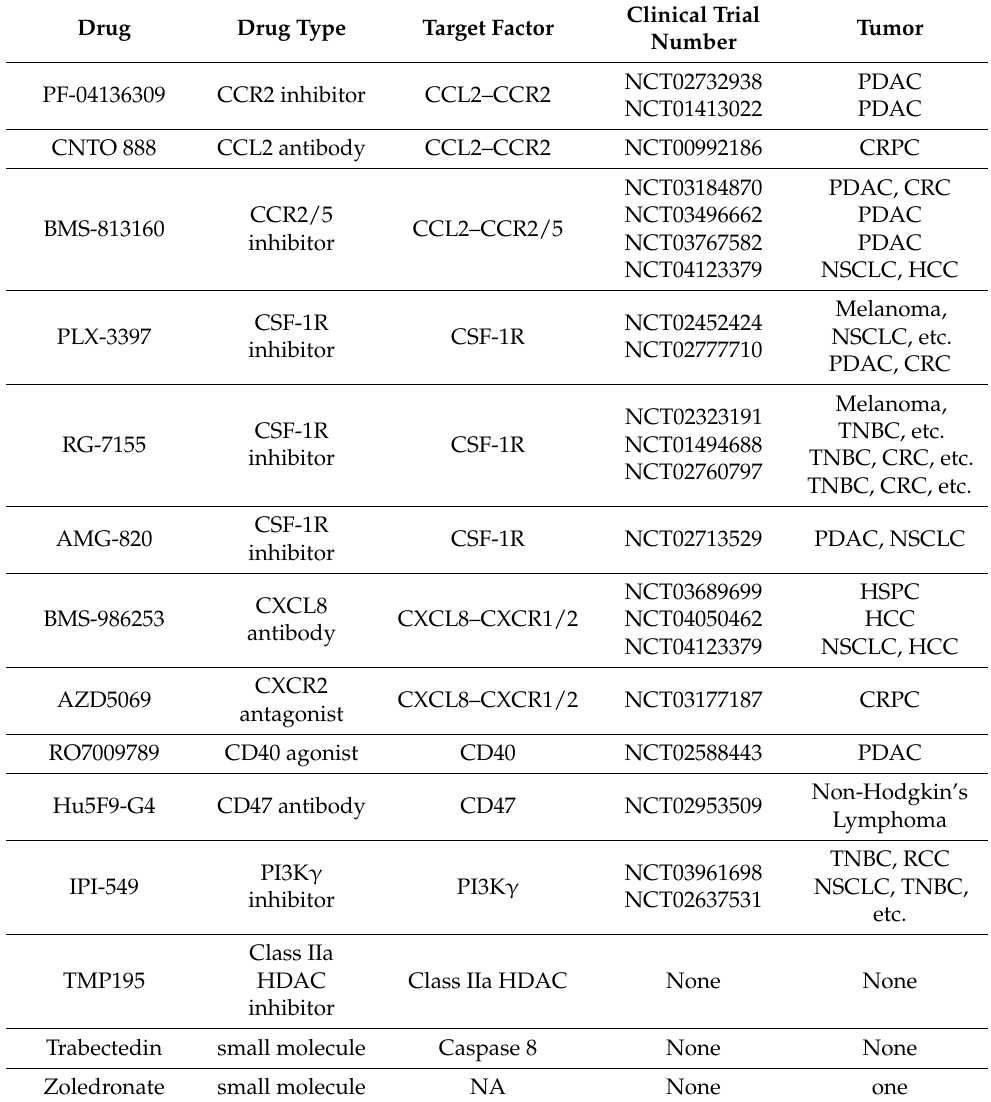
Table 1. Drugs targeting